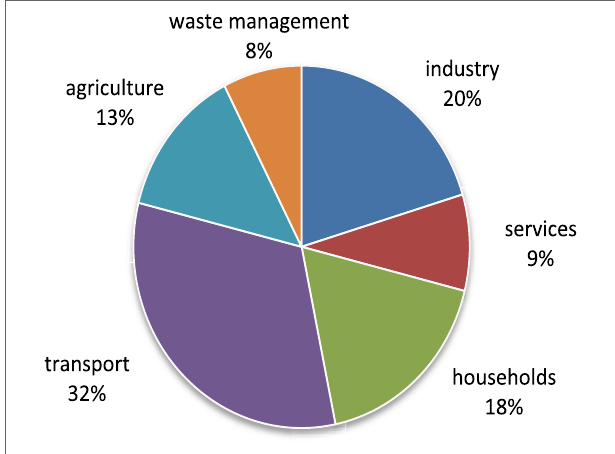
FigUre 2 | Distribution and percentage shares of the CO 2 emitters in Switzerland in 2015 (Bundesamt für Umwelt, 2017).